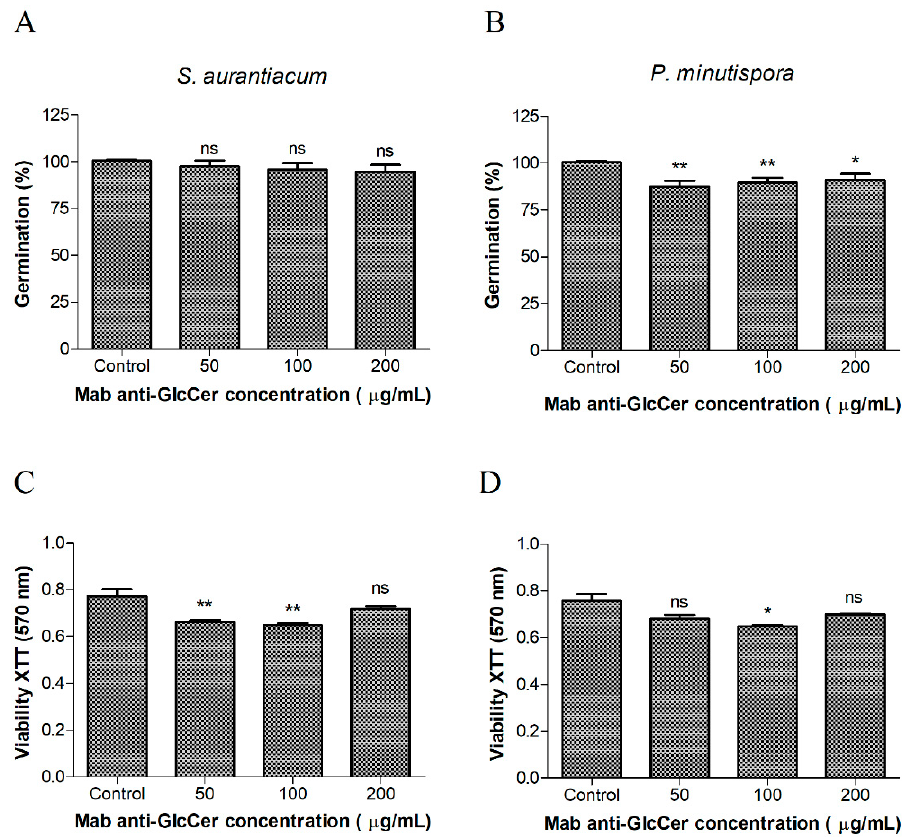
Figure 3. E ff ect of the anti-GlcCerMab (monoclonal antibody) on the germination and viability of conidial cells. Germinated conidia of S. aurantiacum ( A ) and P. minutispora ( B ) in the presence of di ff erent concentrations of anti-GlcCer Mab over 24 h were counted by optical microscopy. At least 100 conidia per field were counted, and the mean value of three independent counts was calculated. Viability assays were performed using S. aurantiacum ( C ) and P. minutispora ( D ) conidia and the anti-GlcCer Mab over 24 h and evaluated using XTT-reduction assay. The absorbance at 570 nm was measured using a spectrophotometer. * p < 0.05, ** p <